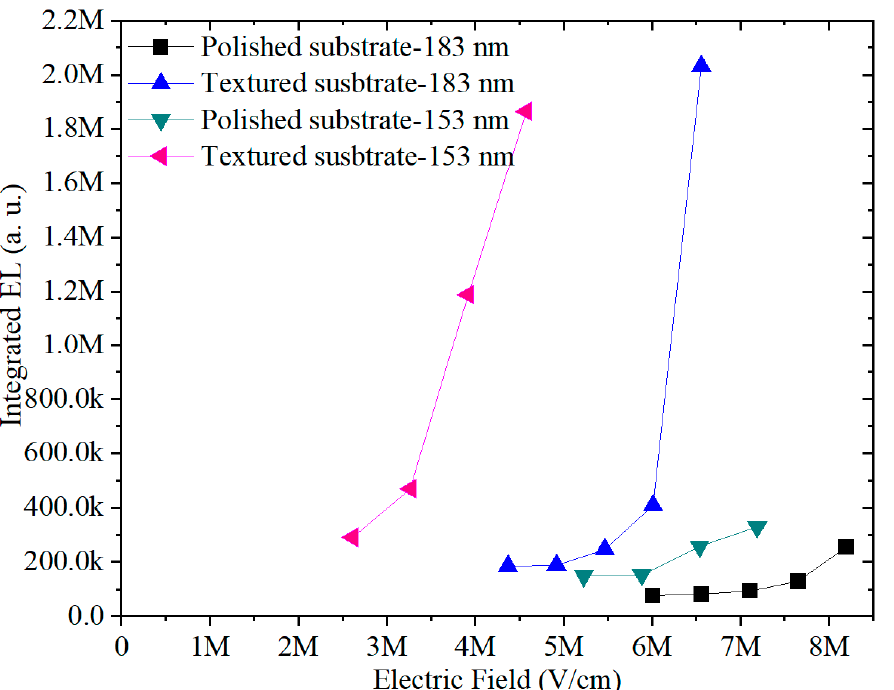
Figure 6. Integral of EL intensity as function of the applied electric field for devices with polished (solid symbols) and textured (empty symbols) substrates; 183 nm and 153 nm refer to film thickness.